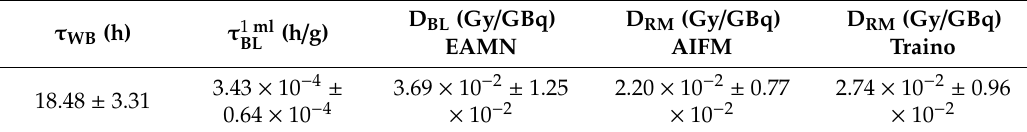
Table 4. Maximum tolerated activity (MTA) values derived from the different dosimetric approaches using 2 Gy as the limit for blood or red marrow absorbed dose.